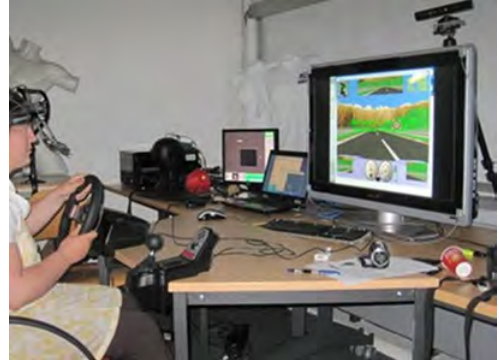
Figure 5. Test person in action in the driving simu-